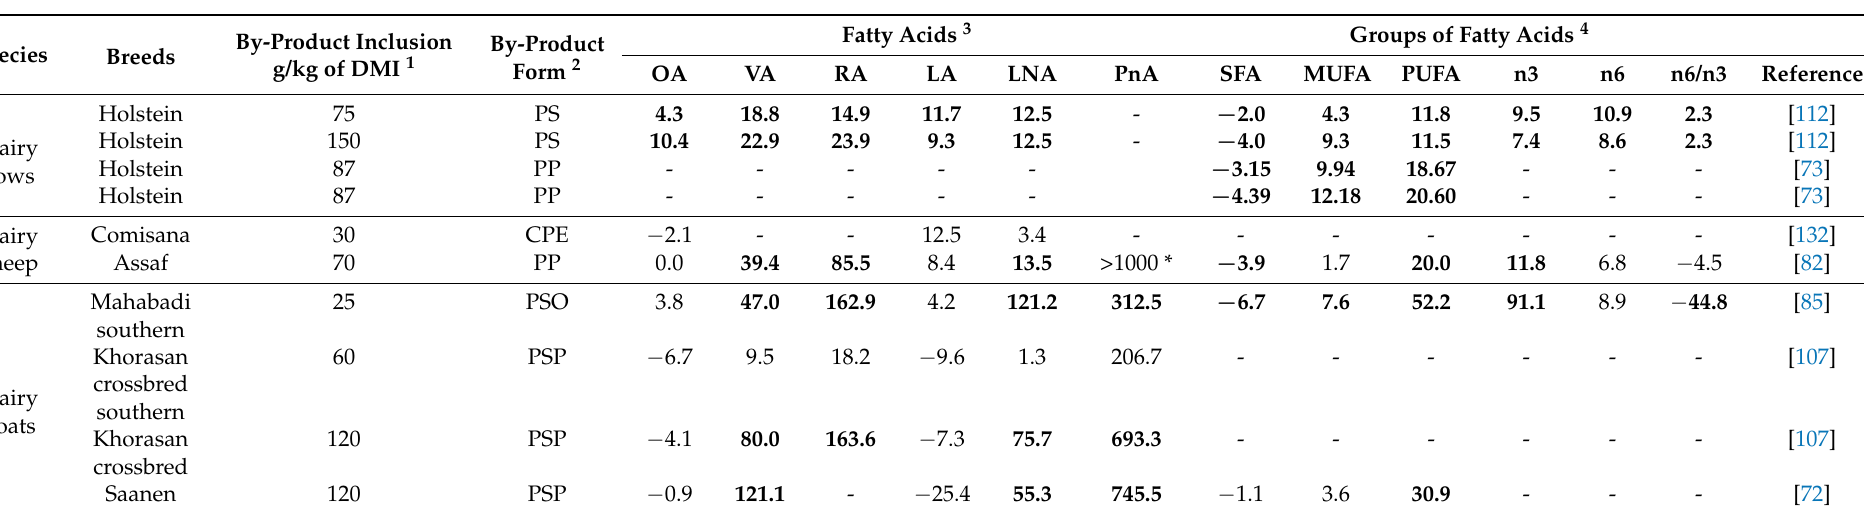
Table 5. Effect of pomegranate by-products included in dairy ruminants’ diets on milk content of oleic acid (OA), vaccenic acid (VA), rumenic acid (RA), linoleic acid (LA), alpha-linolenic acid (LNA) and saturated (SFA), monounsaturated (MUFA), and polyunsaturated (PUFA) fatty acids. Data are reported as the proportional difference between the treatment group, at the respective level of inclusion, and the control